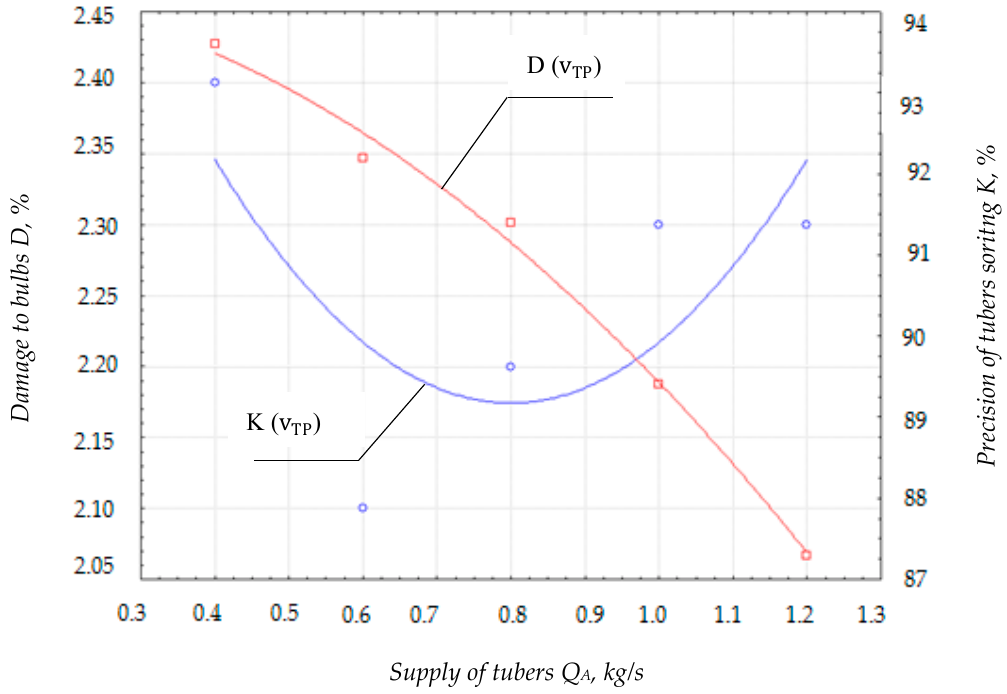
Figure 11. Dependency of the precision of the sorting (K%) and damage to the tubers (D%) on the speed of the forward movement of the transporter’s sorting table.